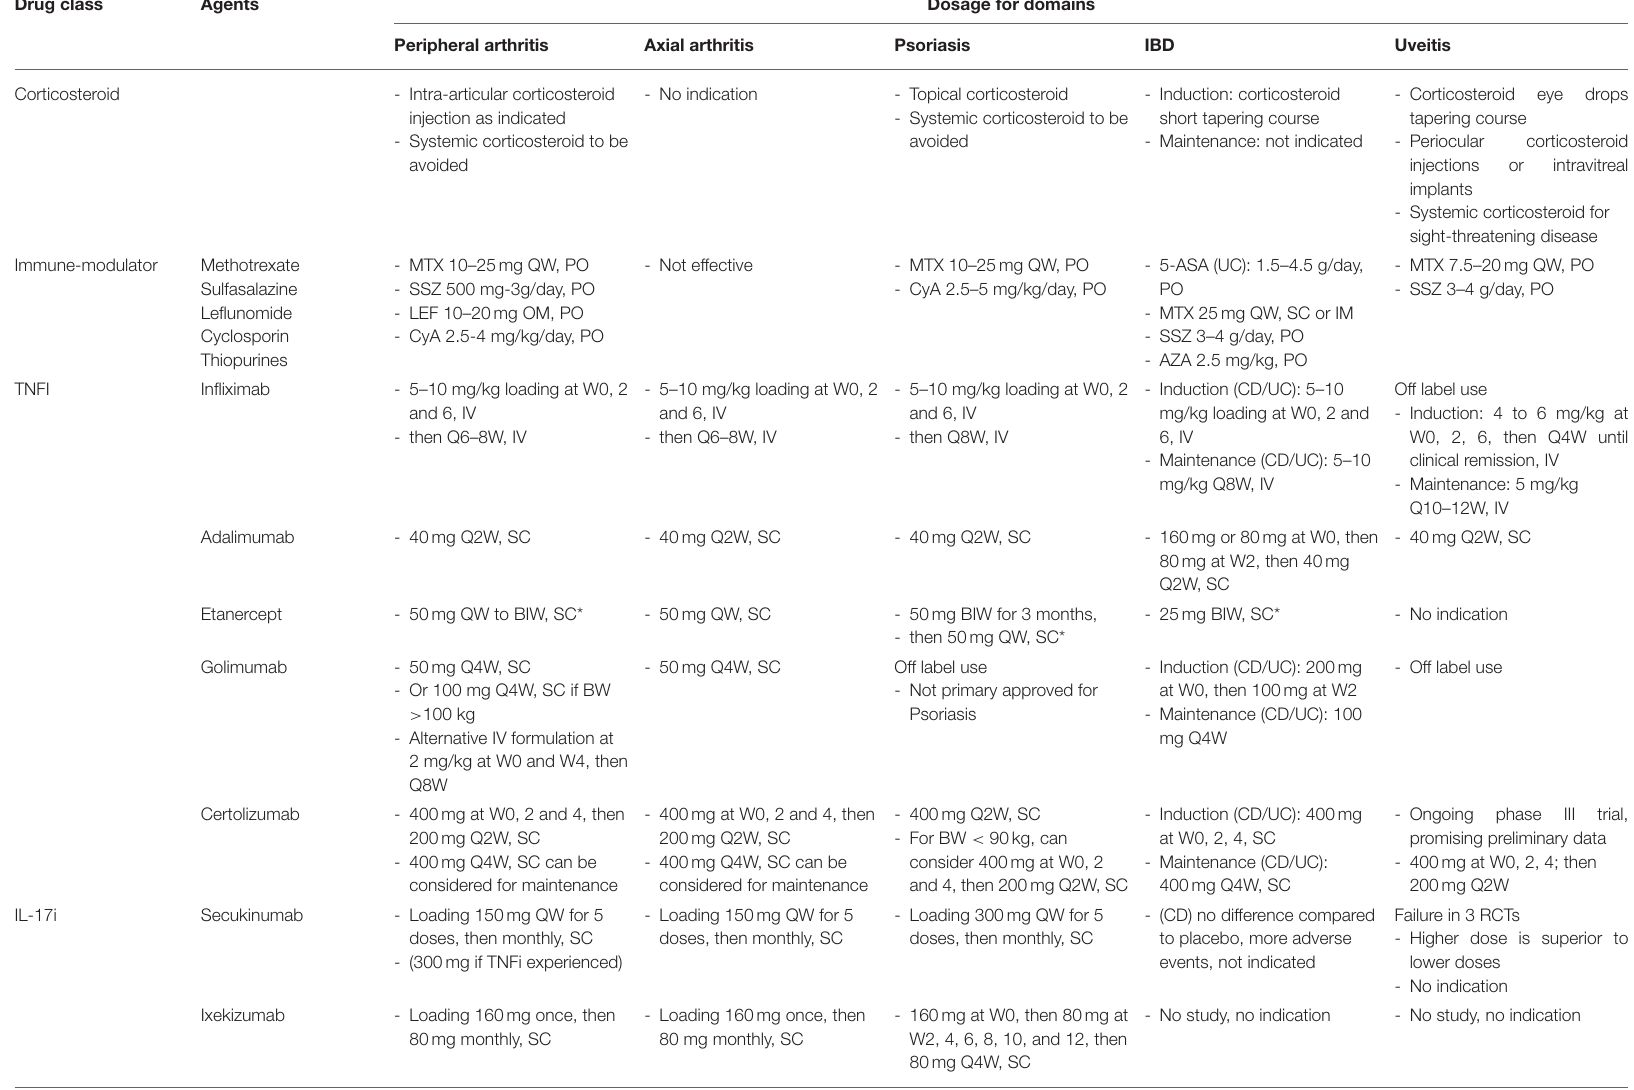
TABLE 1 | Therapeutic options and common dosing regimen for PsD and extra-articular